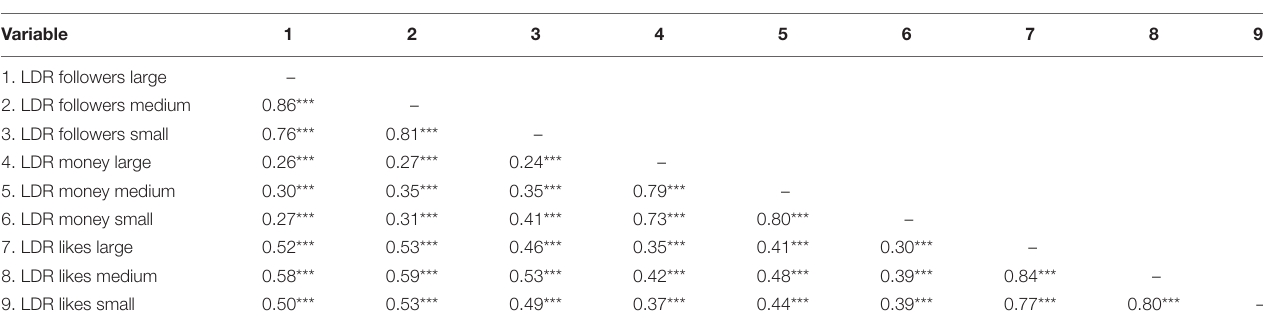
TABLE 2 | Correlations between delay discounting sub-measures.